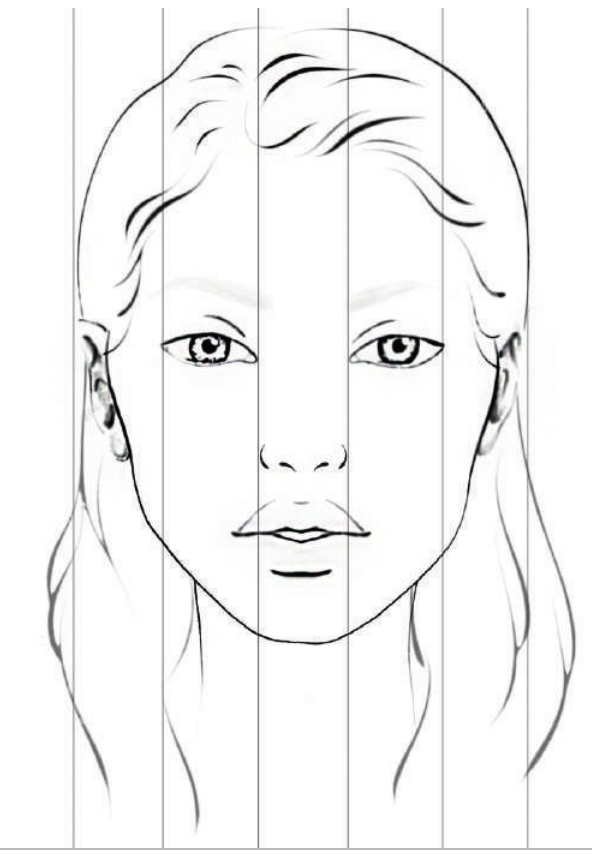
Figure 2. Pilot study flowchart. Figure 2. vertical fifths rule of the face according to neoclassical